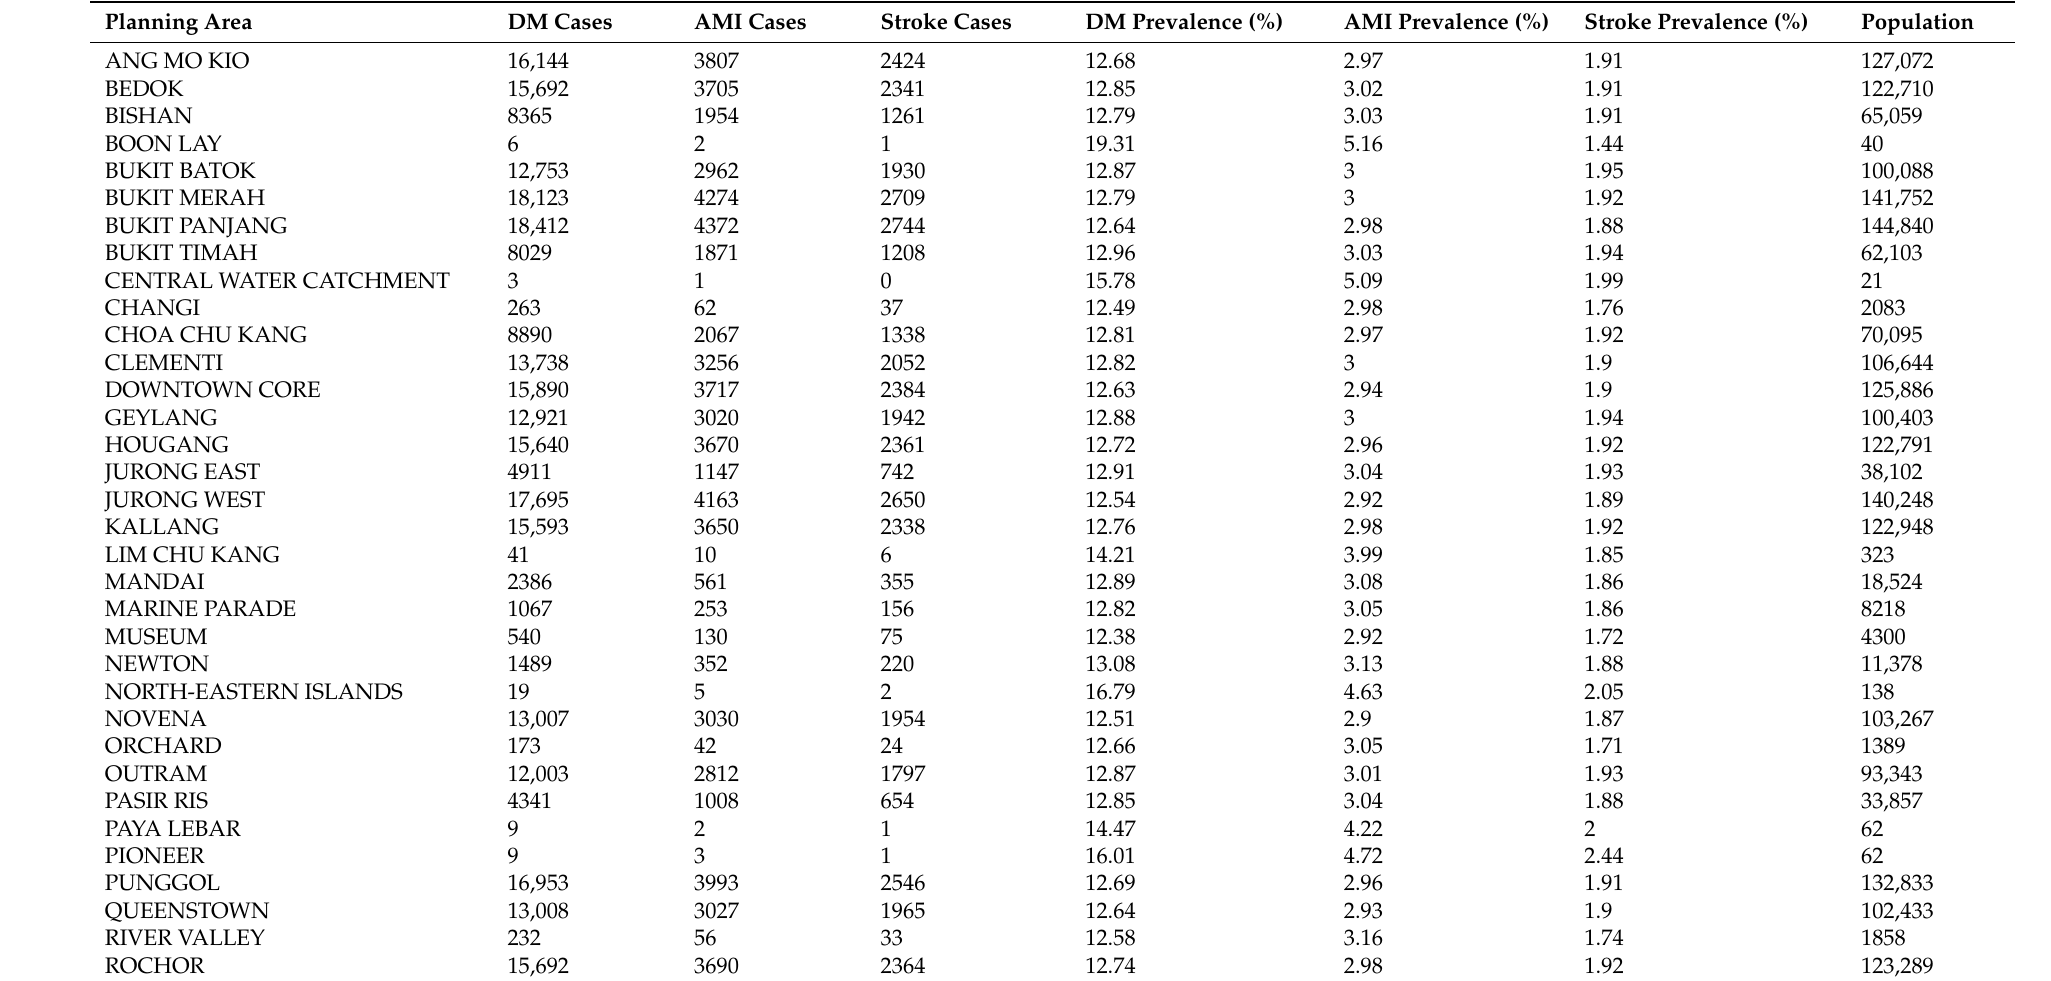
Table A1. Population count, absolute case numbers, and prevalence for DM, AMI, and stroke by planning